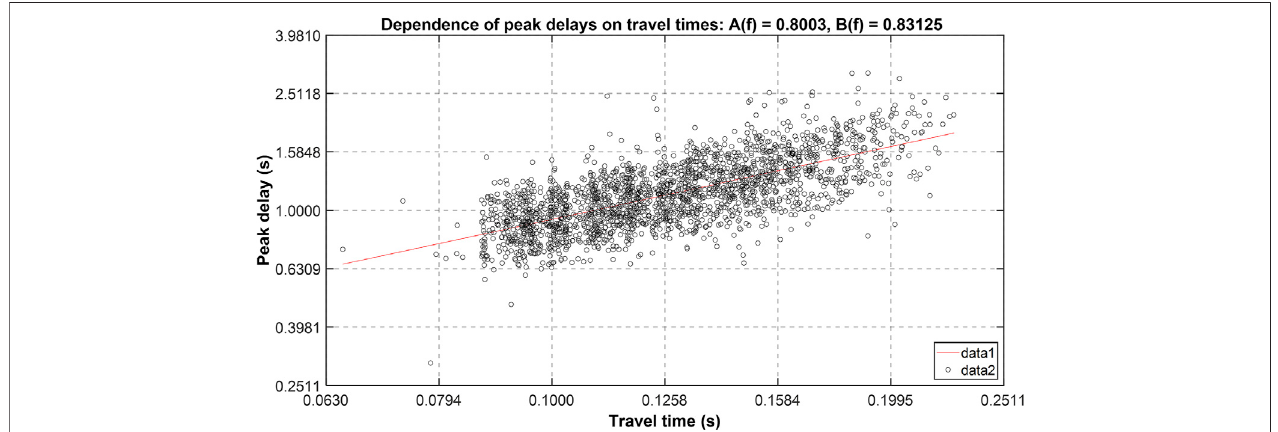
FIGURE3| Peak-delaydependenceontraveltimeat18 Hz.Coef fi cientsAandBde fi nethelinear fi ttingofthedatawith95%con fi dence(A=0.7668±0.8338,B= 0.7941 ± 0.8684). Minimum and Maximum peak delay (0.3 and 5 s respectively) were set to avoid biases on the picking. Given this threshold, the data used for the analysis was reduced to 2081 seismograms at 18 Hz ( Supplementary Table S2